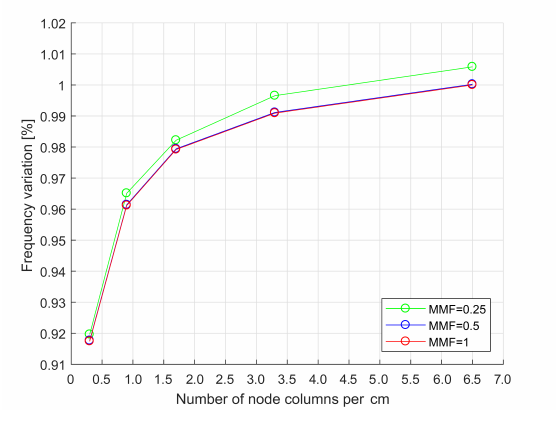
Figure 11. Influence of mesh discretization and of contact node density along X direction.